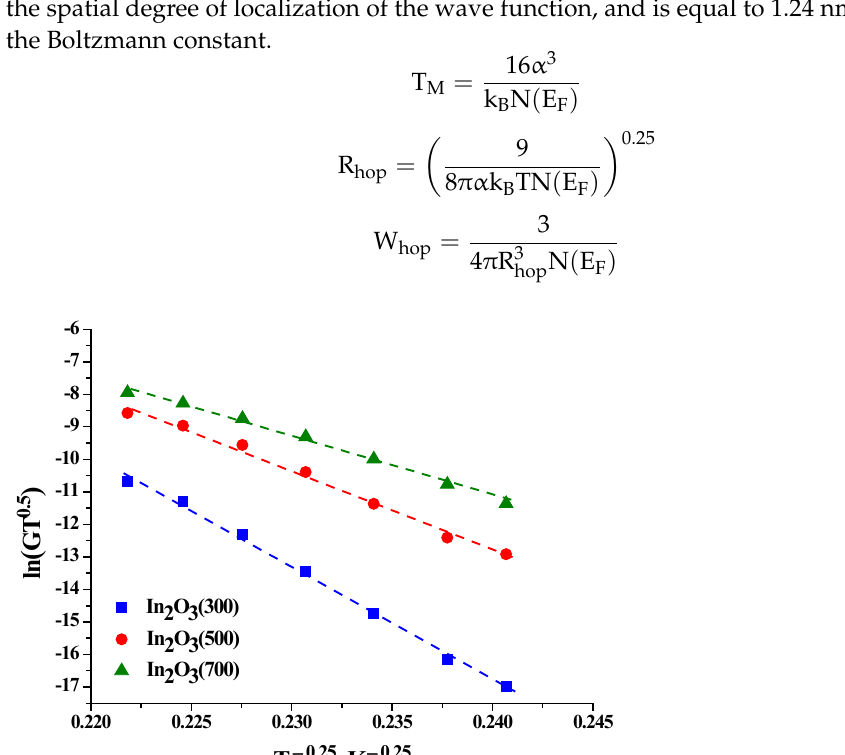
Figure 4. Temperature dependence of conductivity of the In 2 O 3 (300), In 2 O 3 (500) and In 2 O 3 (700) samples in Mott coordinates in the temperature range of 140–25 °C.